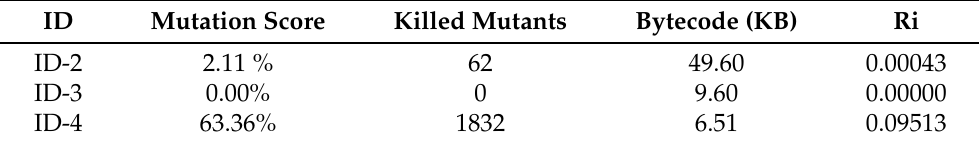
Table 3. Results of participants in the second